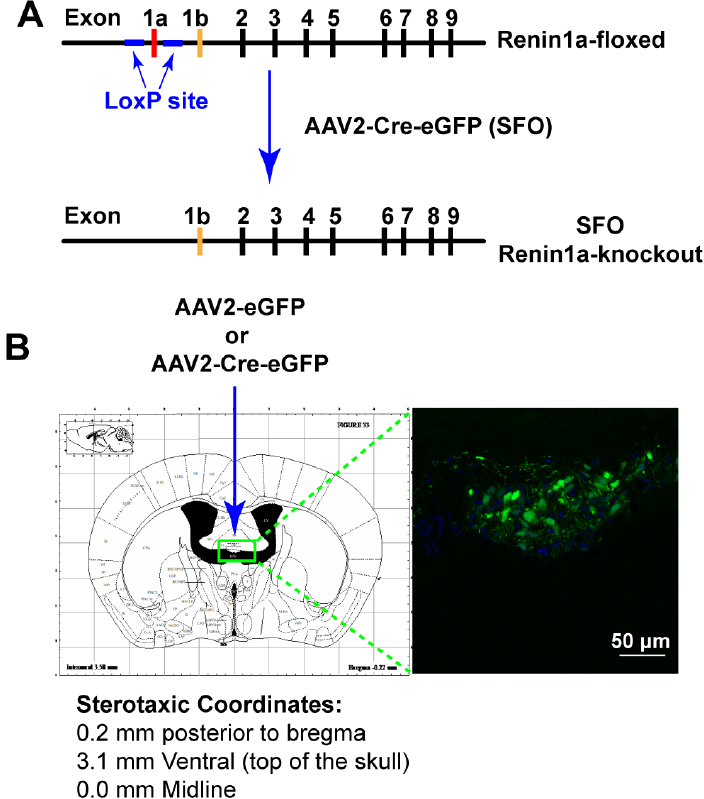
Figure 3. Characterization of SFO-targeted renin-a–KO mice. ( A ) Schematic illustrating Cre-loxP recombination in renin-a–floxed mice. ( B ) Schematic brain atlas and coordinates showing injection sites for AAV2-Cre-eGFP or AAV2-eGFP into the SFO and a representative image of eGFP expression in the